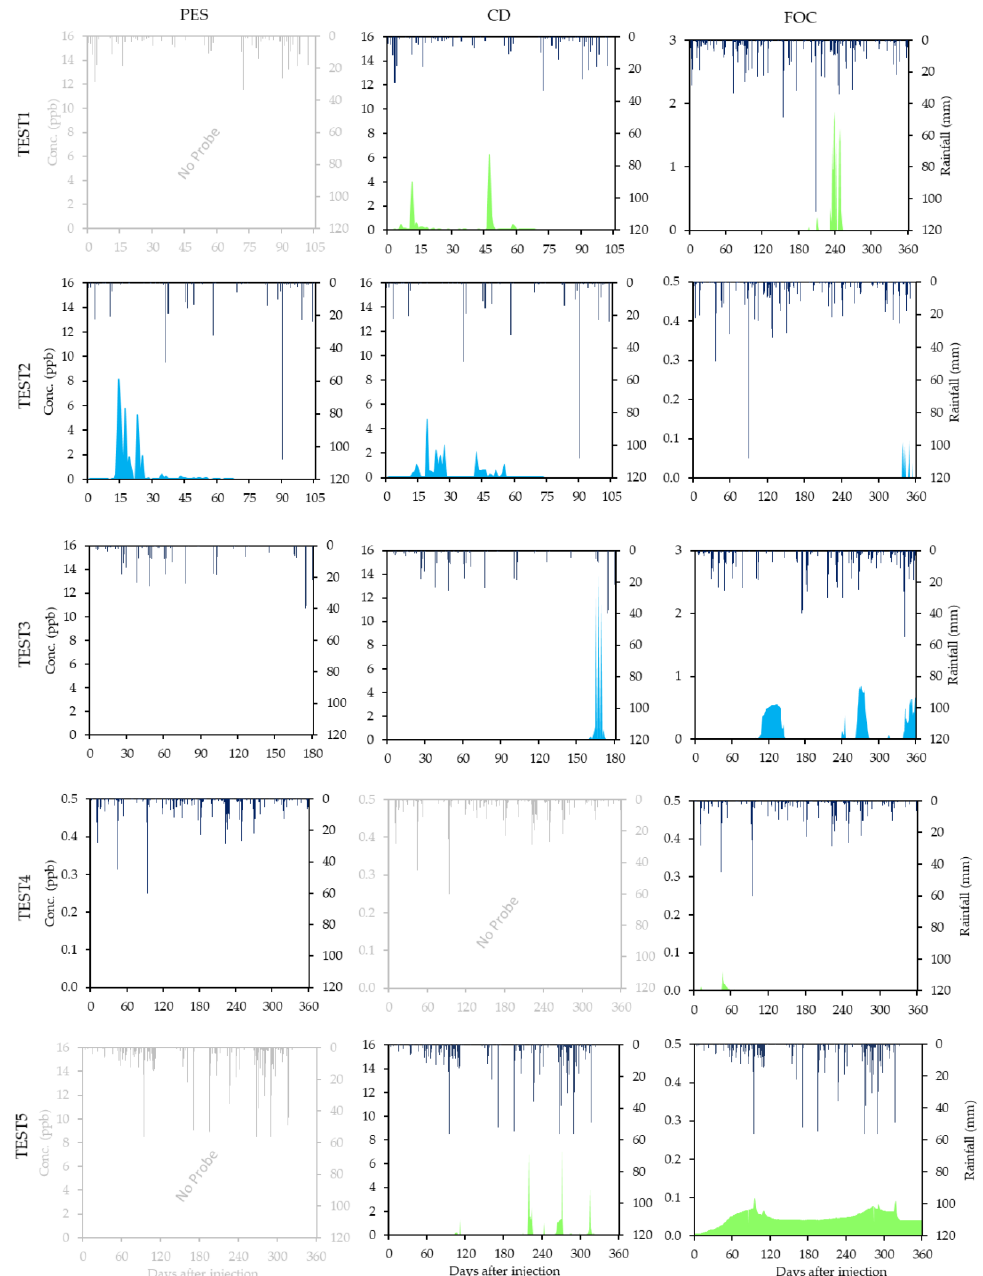
Figure 3. Comparison between tracer concentration expressed in ppb vs days after injection in the monitoring points and rainfall recorded at MTPr during the five analysed tests. The green area represents the Fluorescein, while the blue one the Tinopal CBS-X. When the fluorimetric probe was not installed in a specific spring during a specific test, the corresponding graph is represented in light grey, and the expression “No Probe” is added in the figure.